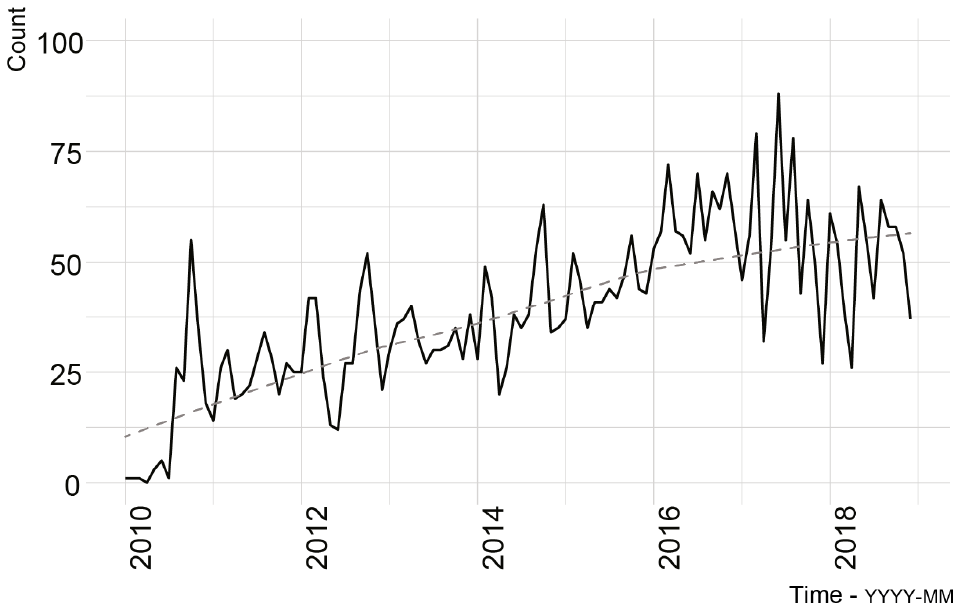
Figure 1. Number of records between January 2008 and December 2018 (solid) and lowest regression line (dashed).